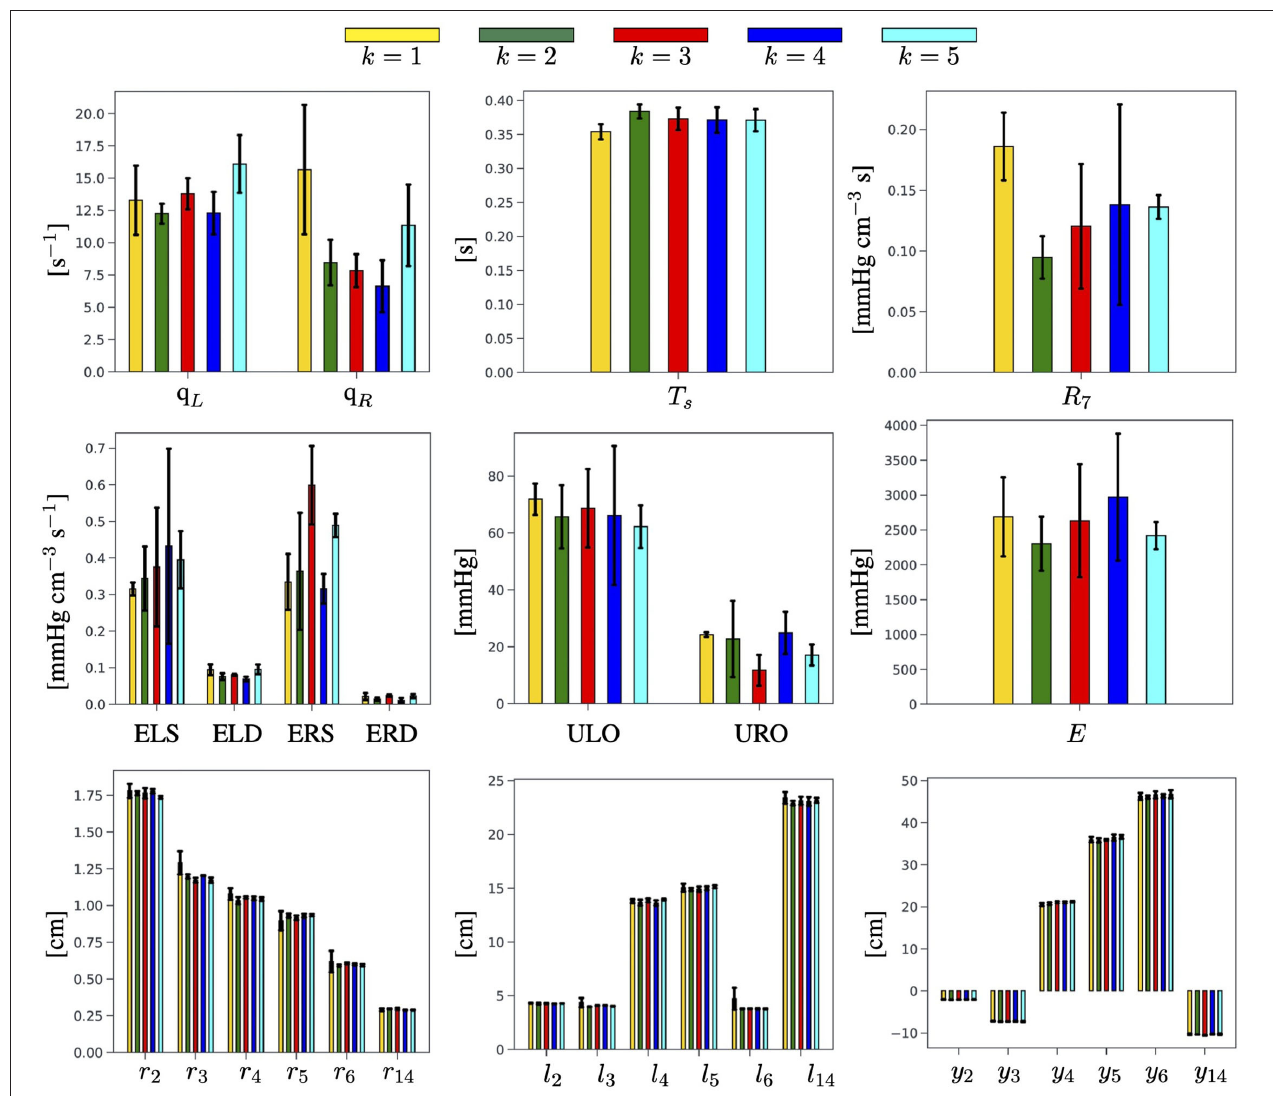
FIGURE 5 | Summary of the physiological and anatomical parameters estimated by the EA for each of the k = 1, ... ,5 selected BCG objective curves for Subject